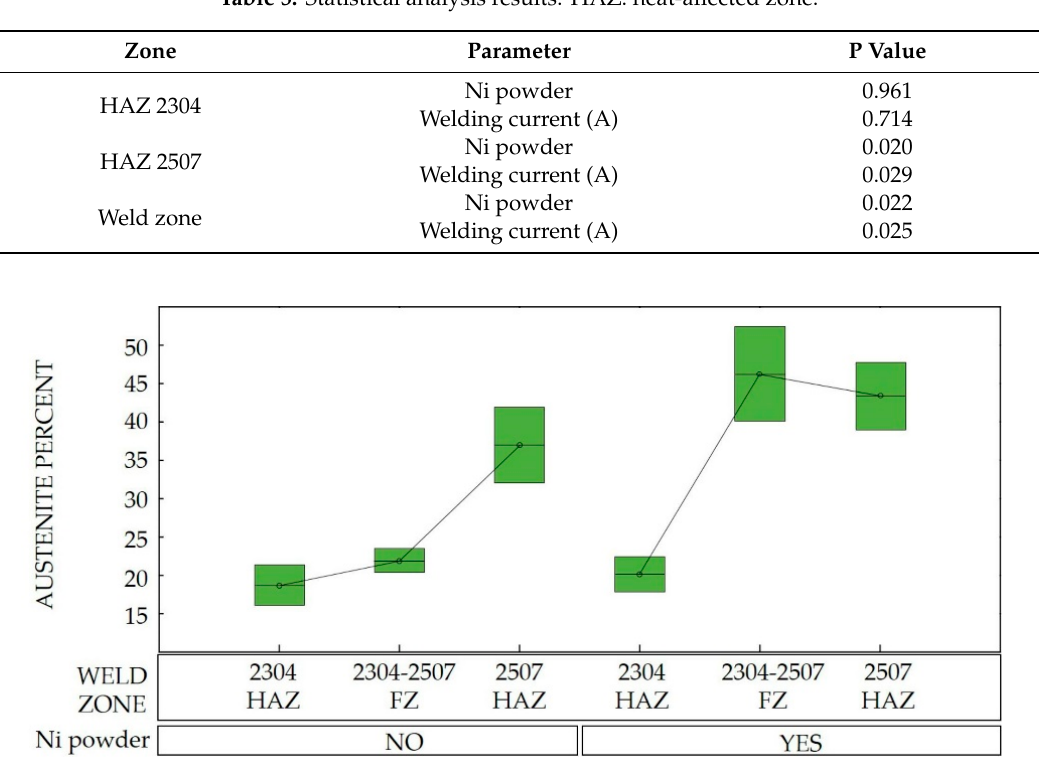
Table 5. Statistical analysis results. HAZ: heat-affected zone.